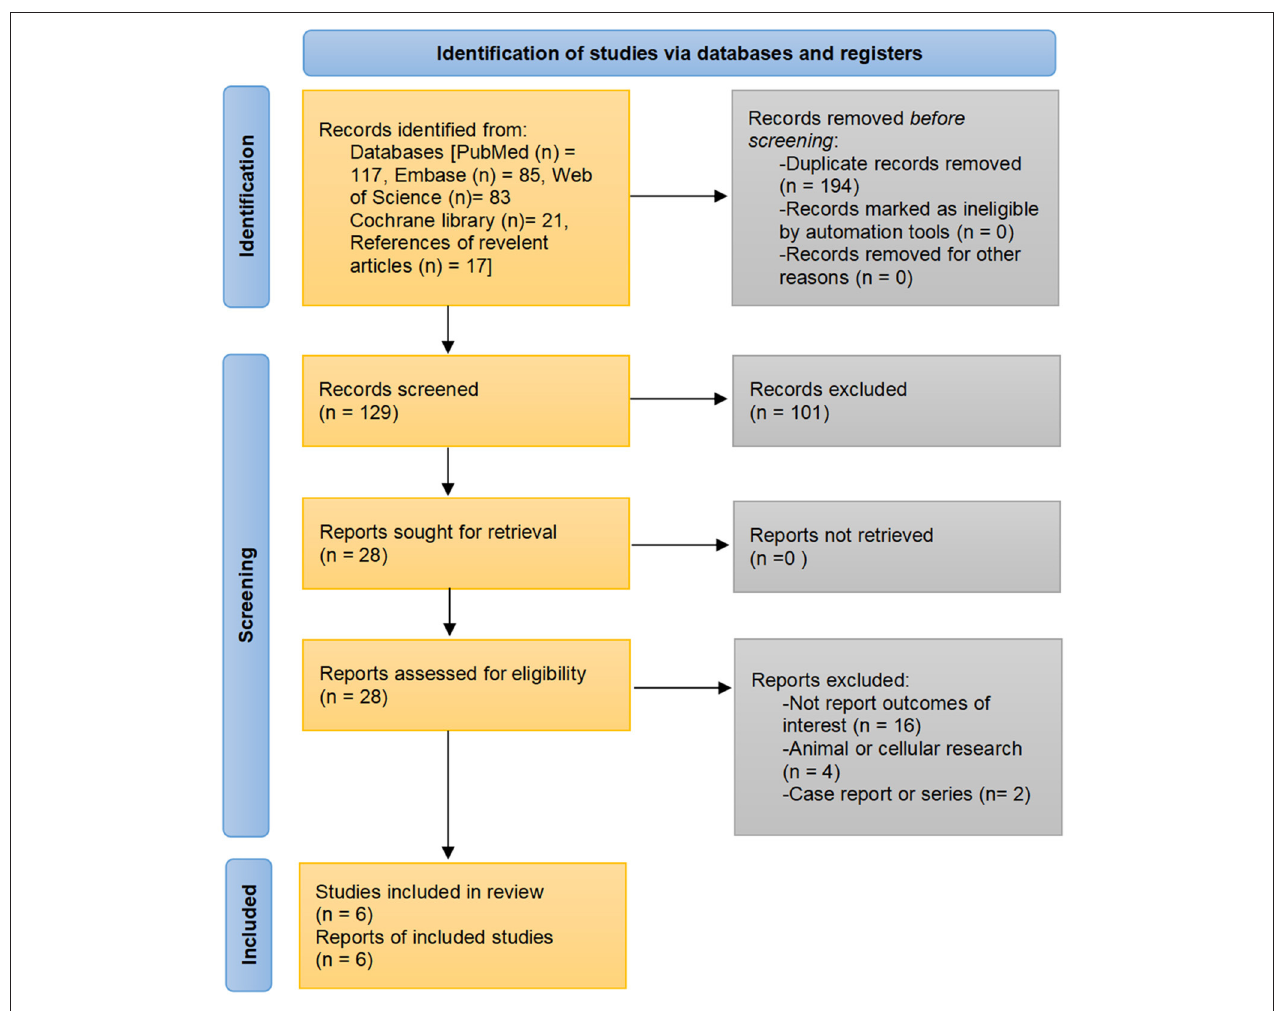
FIGURE 1 | Flowchart of study